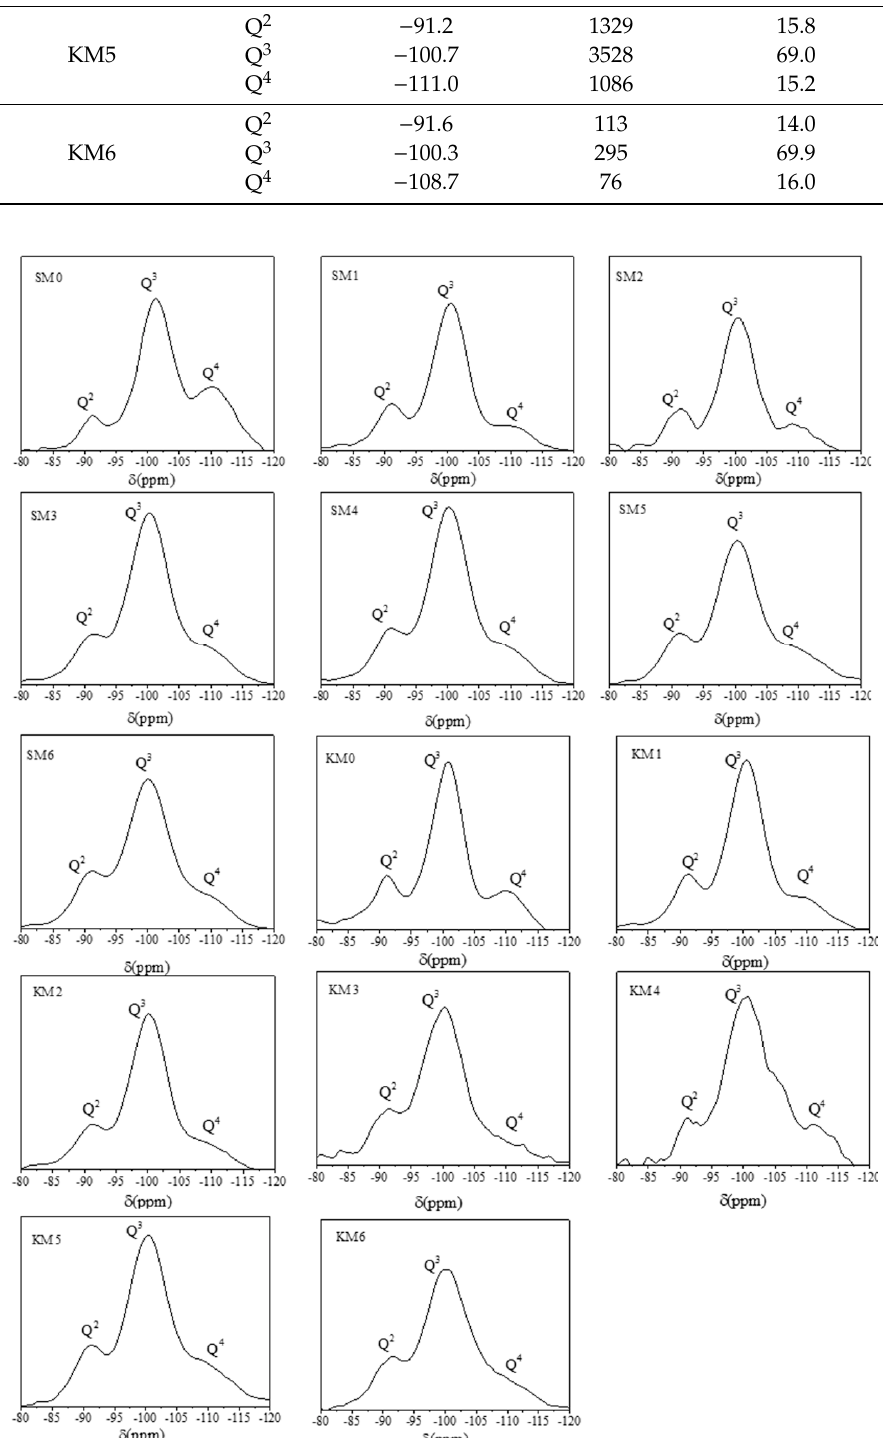
Figure 6. 1 H decoupled 29 Si solid-state magic-angle spinning (MAS) nuclear magnetic resonance (NMR) spectra of the SBA-15 and KIT-6 samples calcined under different conditions.